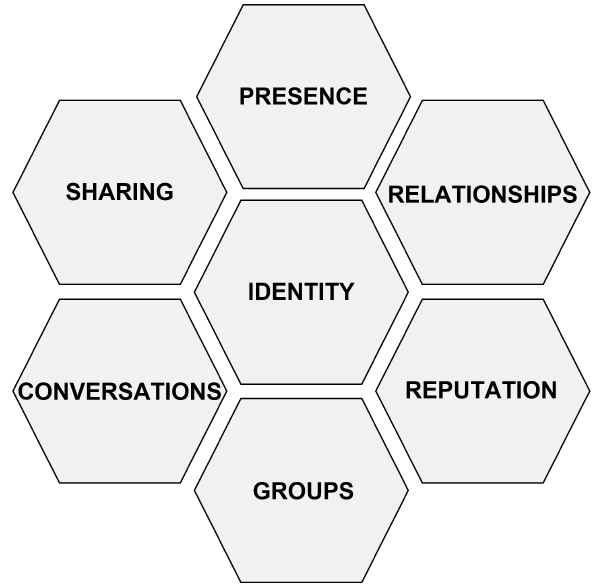
Figure 2. BeingExample honeycomb model.